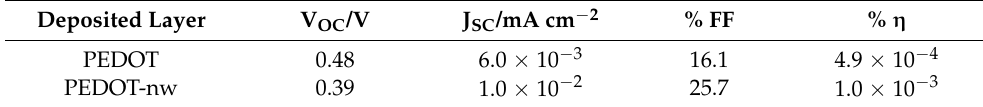
Table 1. Current-voltage (J-V) characterization photocells using bulk and nanowired PEDOT layers. Deposited